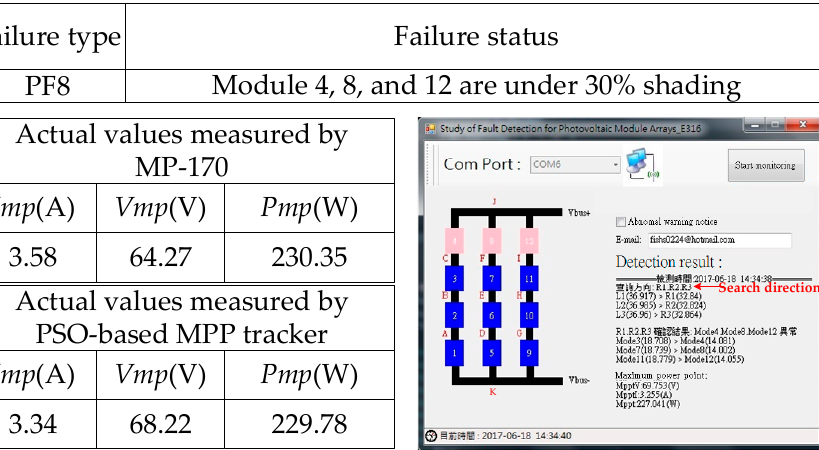
Figure 22. Experimental outcome of failure type PF7.